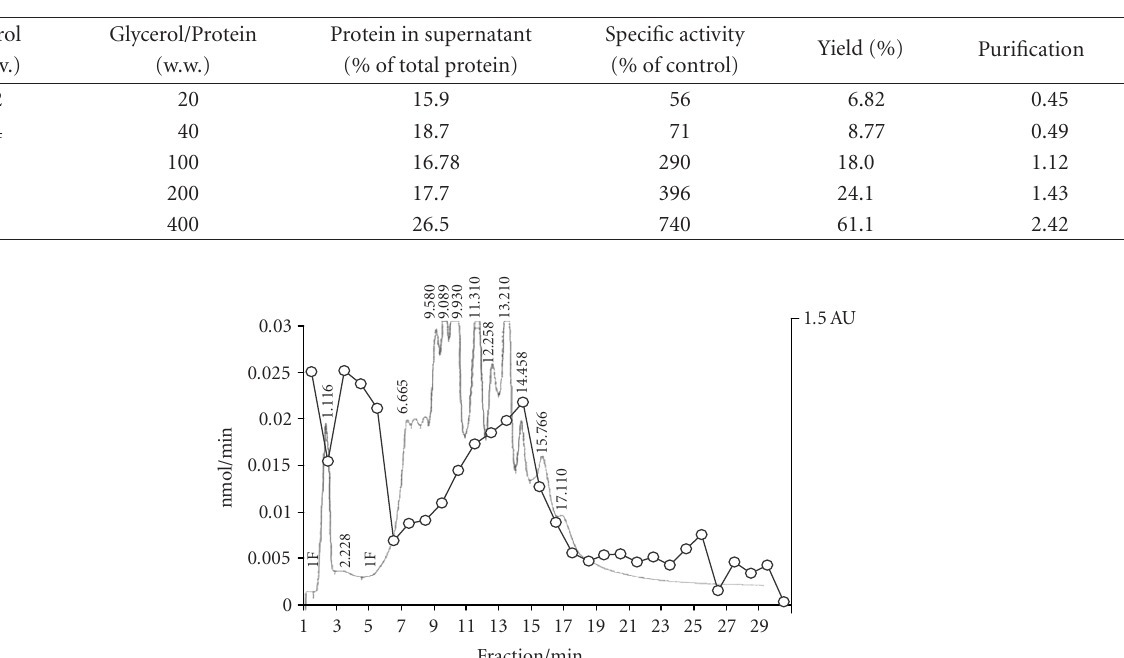
Table 4. E ff ects of glycerol concentrations on the solubilization of lyso-PAF AT from membrane fraction of human kidney tissue. Data represent the average of two experiments with duplicate determinations.